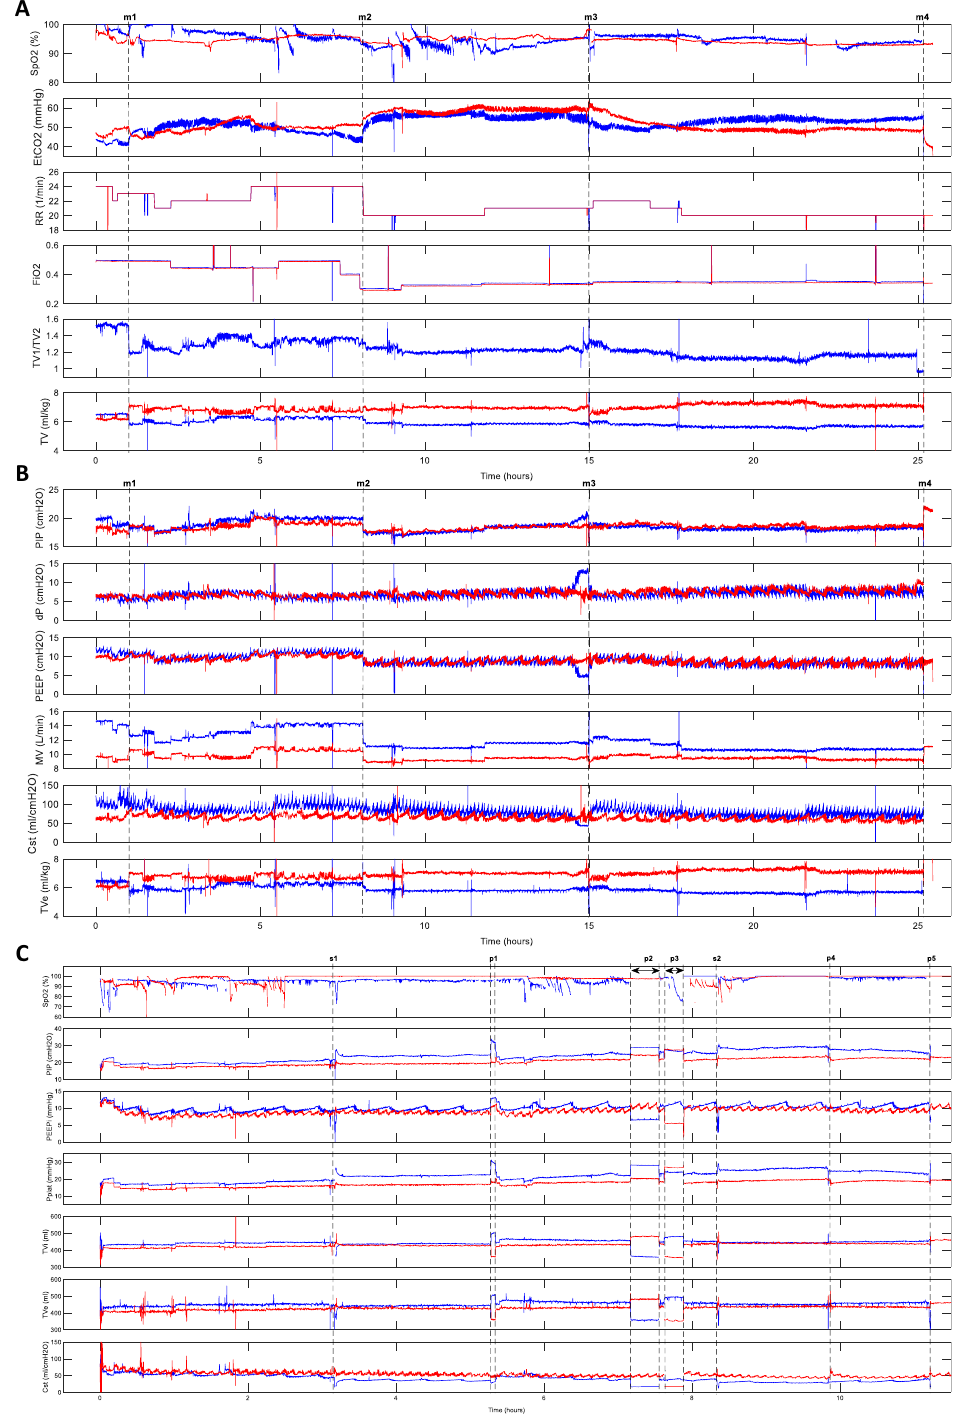
Figure 2. Time traces for the selected animal experiments. ( A , B ) Ventilatory parameters over time for Experiment (pair) 6. ( C ) Ventilatory parameters for Experiment 3. Blue traces denote object #1, while red traces denote object #2 (except TV1/ TV2 ). Markers: m1, Changing the Ventil flow division knob; m2, Respiratory rate reduction; m3, Animal position change from the left side to the right side; m4, One object being exchanged with a 2 L respiratory bag; S1, Injection of the first 100 ml of saline to pig #1; p1, Flow division changes by the Ventil; p2 and p3, The times when a 2-L respiratory bag was connected instead of pig #1 and #2, respectively; s2, Injection of the second 100 ml of saline to pig #1; p4, Animal position change from the right side to the left side; p5, Exchange of the #1 object with a 2 L respiratory bag; MV, Minute ventilation; TV, Tidal volume; FiO 2 , Oxygen fraction in the inhaled gas; SpO 2 , Arterial blood saturation; EtCO 2 , End-tidal carbon dioxide; TV1/ TV2, Tidal volume ratio—ventilation ratio; PIP, Peak inspiratory pressure; Pplat, Plateau pressure; PEEPi, Intrinsic positive end-expiratory pressure; ΔP, Driving pressure (Pplat–PEEPi); TVe, Expiratory tidal volume, Cst, Static lung